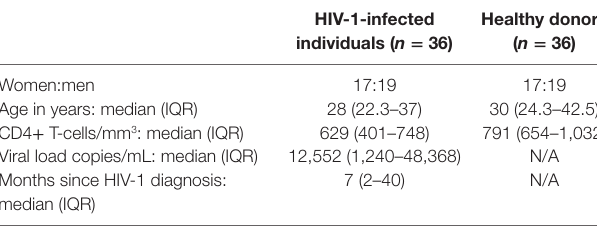
Table 1 | Demographic features of enrolled individuals.